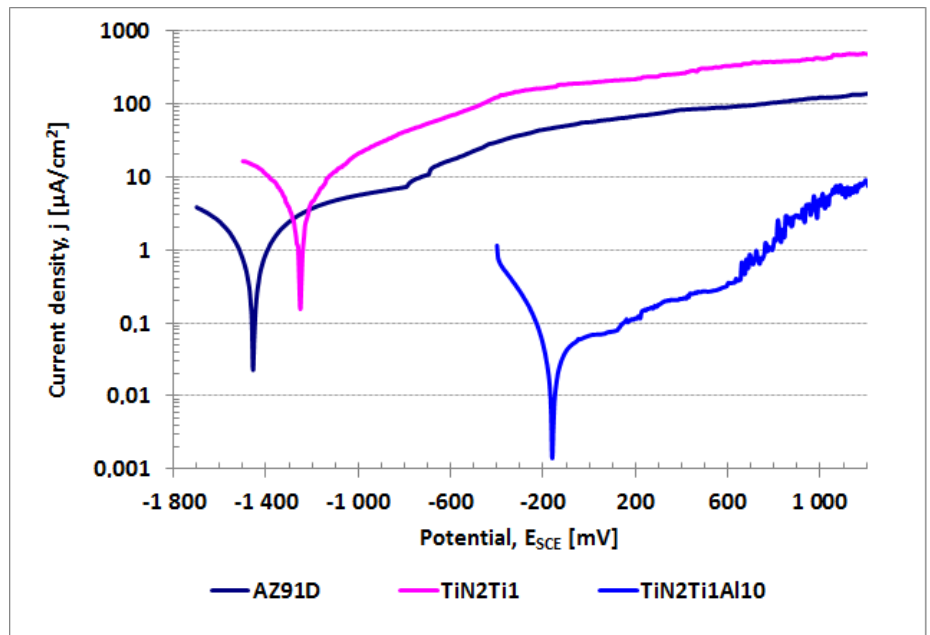
Figure 8. Polarization curves in deionized water for magnesium AZ91D alloy uncoated (AZ91) and coated with various types of titanium nitride surface layers: TiN-Ti-Al type with a titanium and aluminum sub-layer and, TiN-Ti type with titanium and without aluminum sub-layer, both in as-deposited variants (TiN2Ti1Al10 and TiN2Ti1_S, respectively).